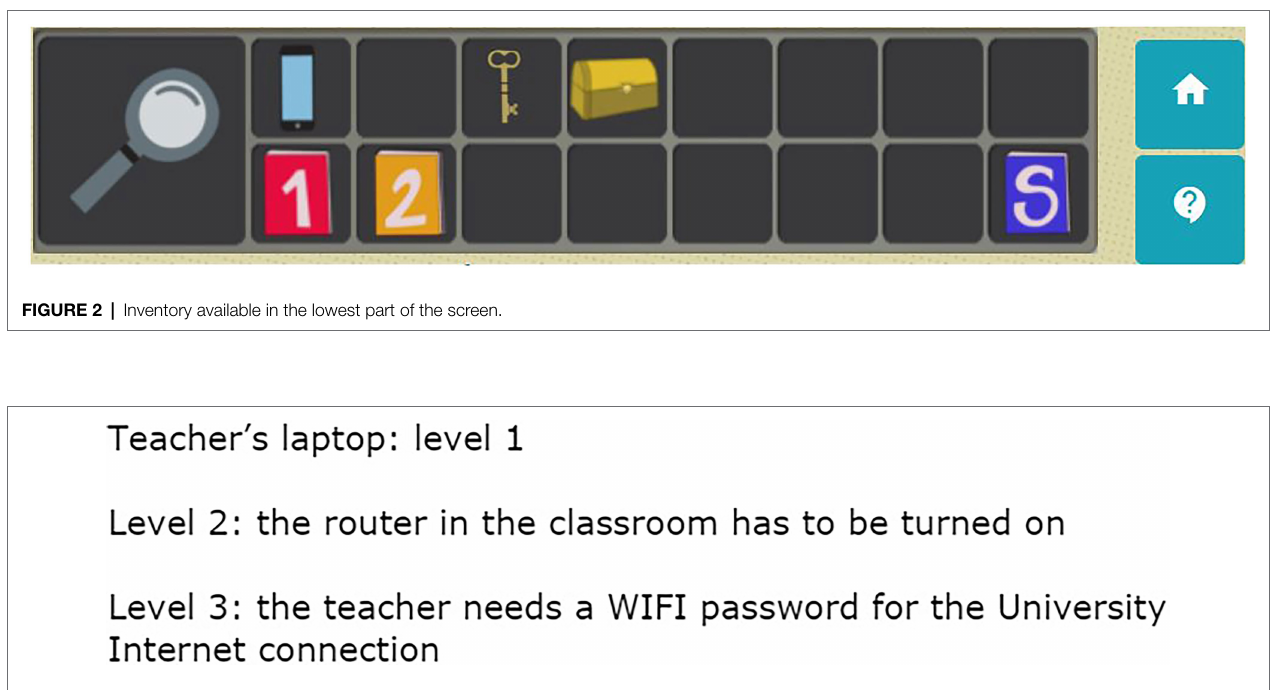
FIGURE 3 | Part of the design